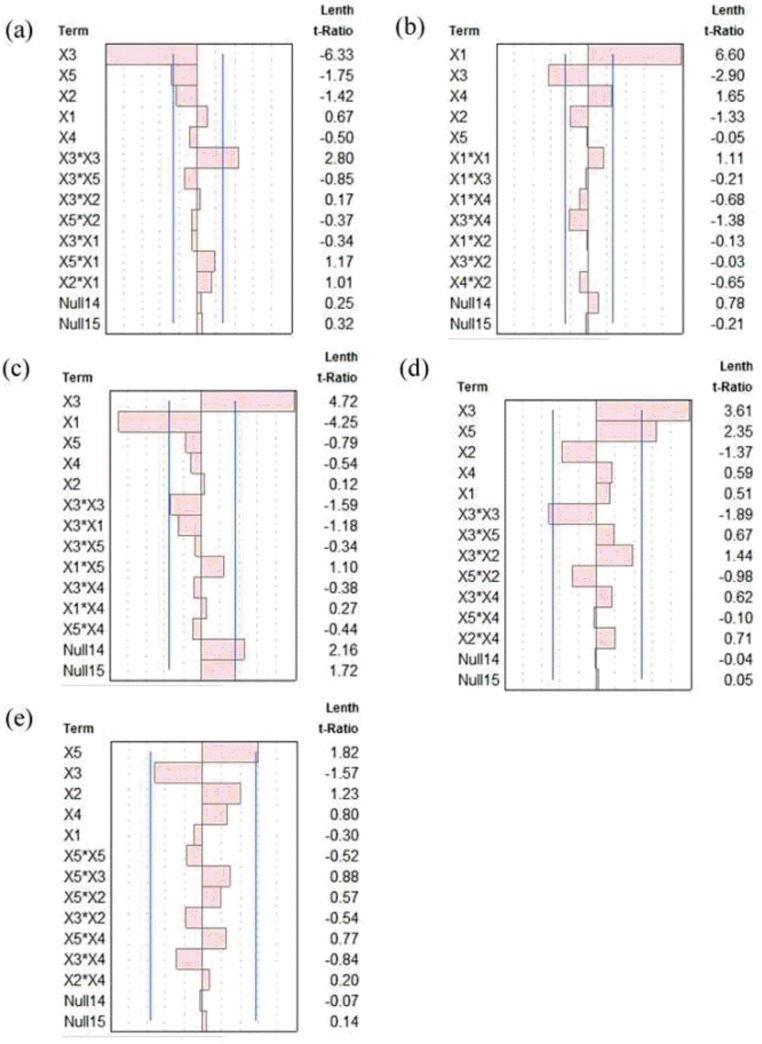
Standard Pareto chart showing the effects of various process factors on (a) flowability, (b) temperature, (c) moisture, (d) aggregation index, and (e) compactability.